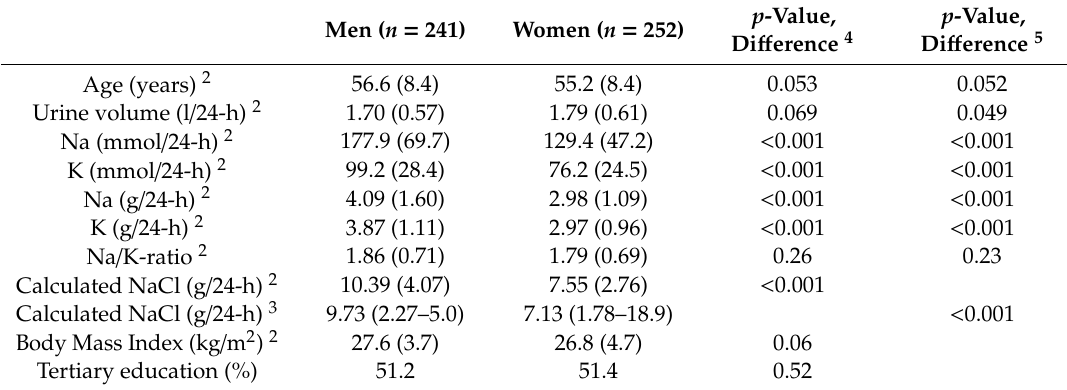
Table 1. Characteristics 1 of men and women who collected 24-h urine in the seventh wave of the Tromsø study 2015–2016 ( n = 493).